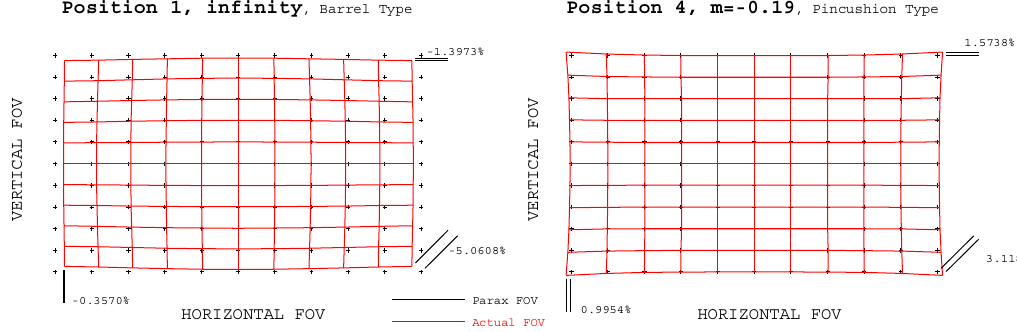
Figure 10. TV distortion of the final designs at the infinite and nearest distance.